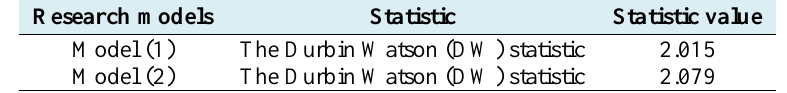
Table 7. The results of testing the absence of residual autocorrelation in the BSE